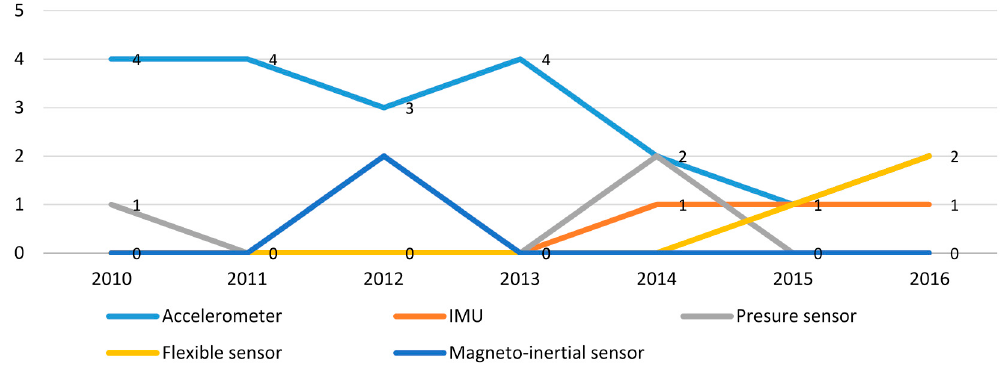
Figure 1. Trends of sensor technology usage in baby-related movement monitoring research. Figure 2. Trends of sensor technology usage in baby-related movement monitoring